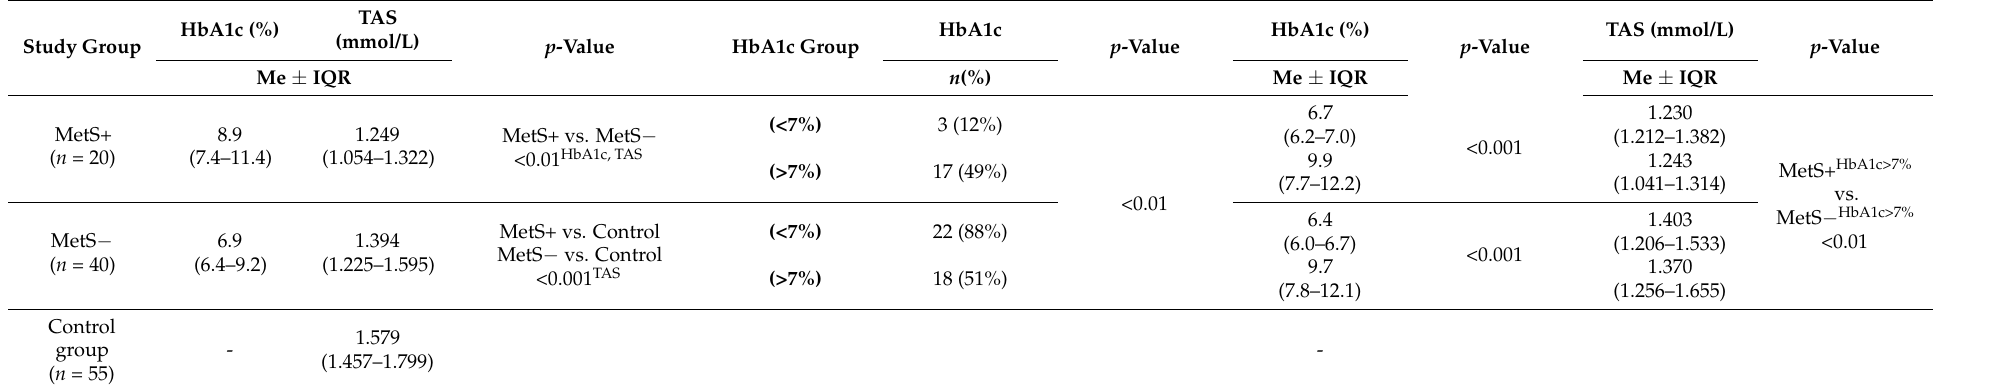
Table 5. HbA1c and TAS values, depending on metabolic